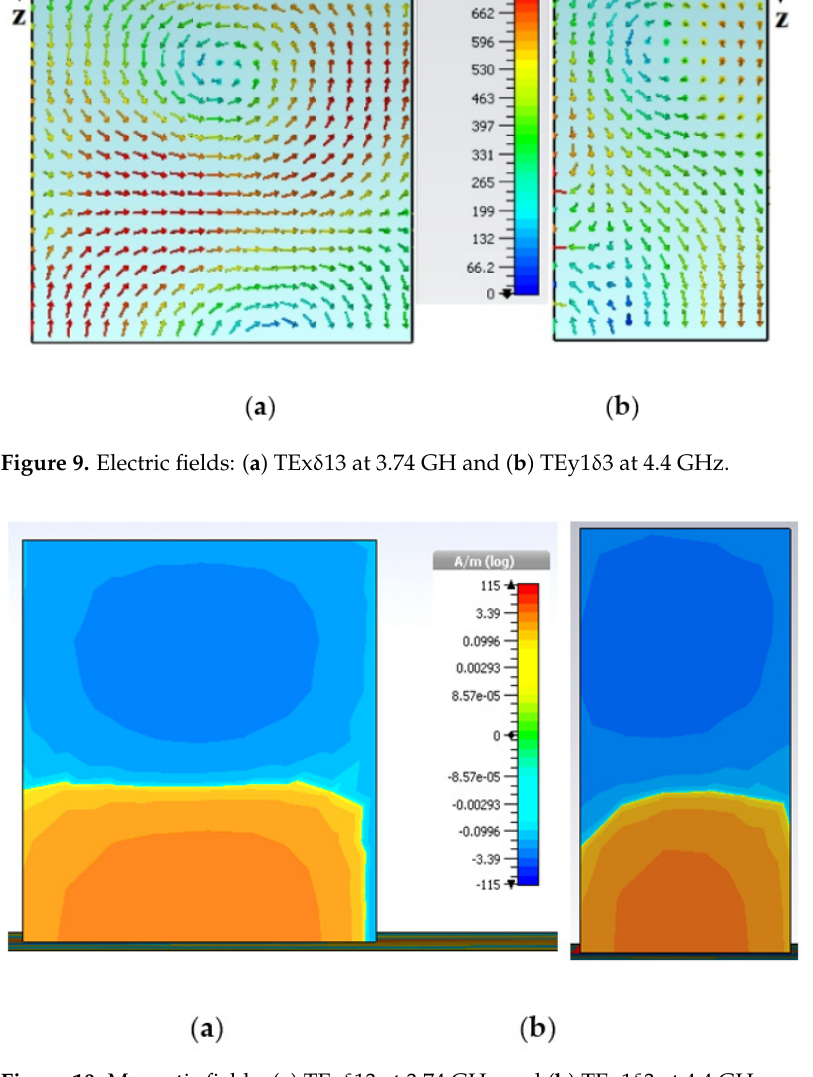
Figure 10. Magnetic fields: ( a ) TEx δ 13 at 3.74 GHz and ( b ) TEy1 δ 3 at 4.4 GHz.